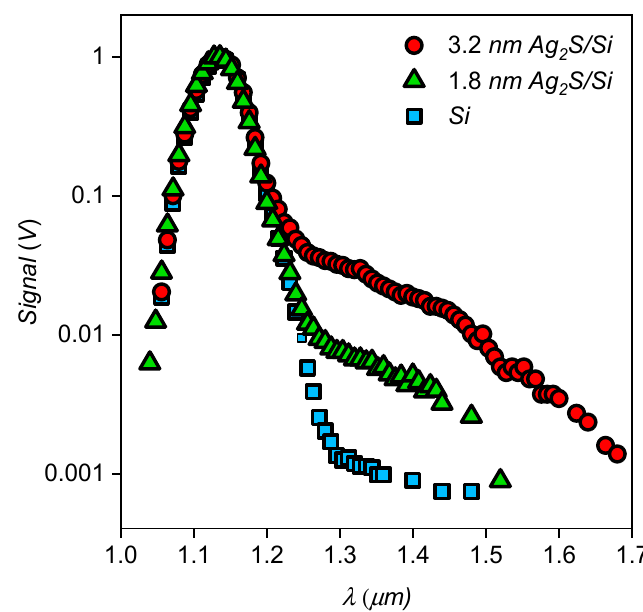
Figure 5. Spectral response curves of the uncovered Si and Ag 2 S/Si heterostructures. The comparison of the curves reflects a sub-band gap IR photon absorption in Si.